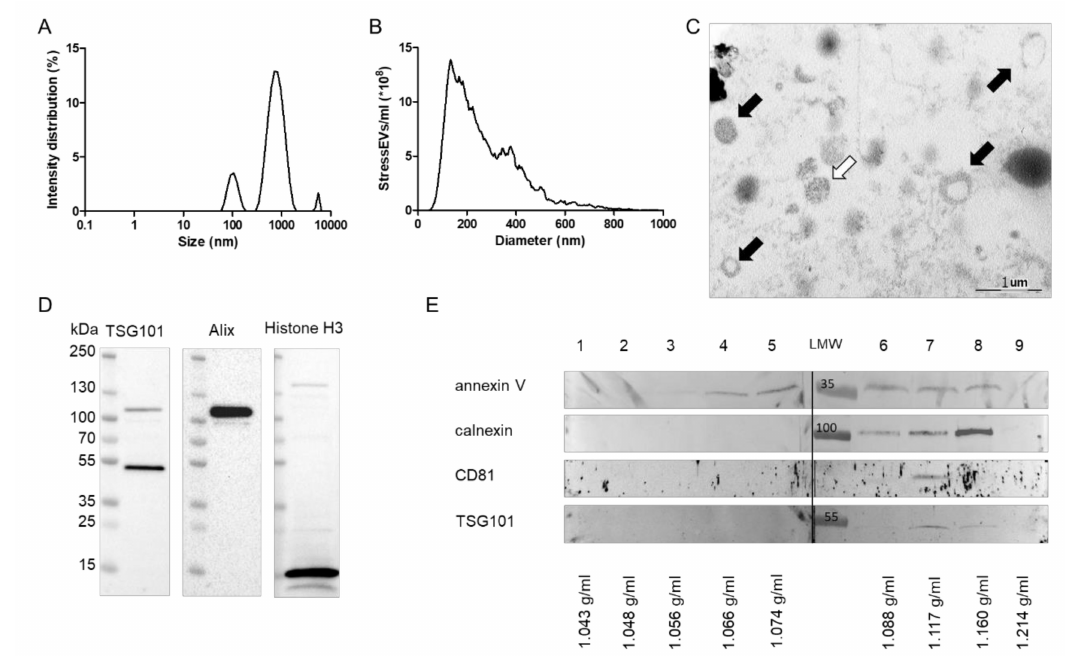
Figure 1. Characterization of stressextracellular vesicles (EVs). HEK293 cells were treated with calcium ionophore for 1 h and stressEVs were isolated. ( A ) Dynamic Light Scattering (DLS) analysis of an isolate showing the intensity distribution of EVs. ( B ) Nanoparticle tracking analysis (NTA) of EV preparations. ( C ) Electron microscopic images of a representative EV preparation. Black arrows: EVs, and white arrow: nuclear material. ( D , E ) Western blot analysis of EVs showing that EVs and nuclear material were present in our